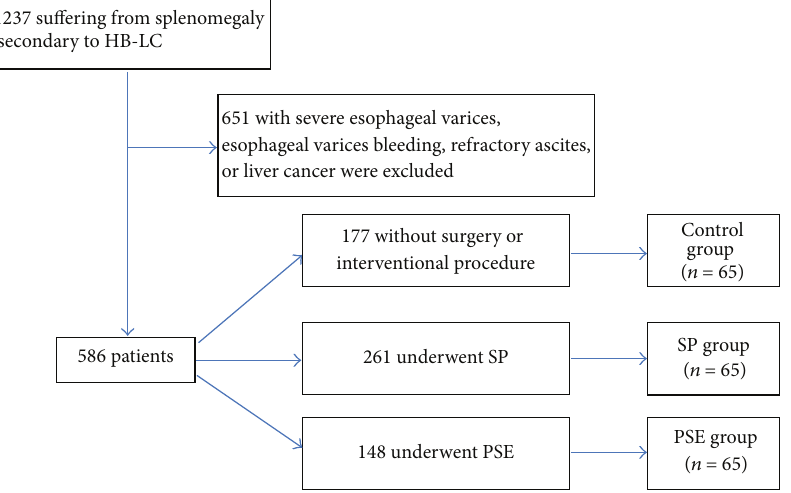
Figure 1: Flow diagram outlining the study